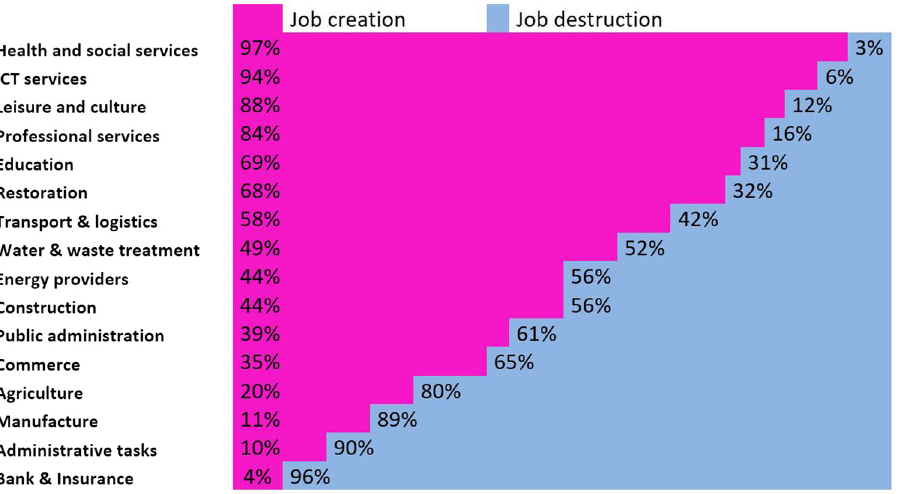
Figure 3: Job creation and destruction in di ff erent sectors, 2018 Questionnaire New technologies and the future of work [ 15 ]